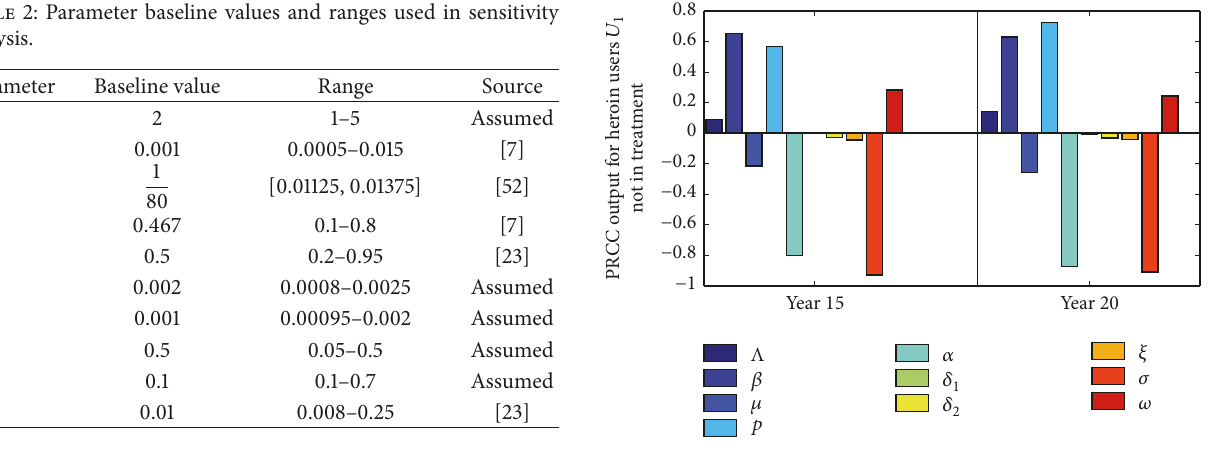
Figure 8: The PRCC output for heroin users 𝑈 1 (𝑡) not in